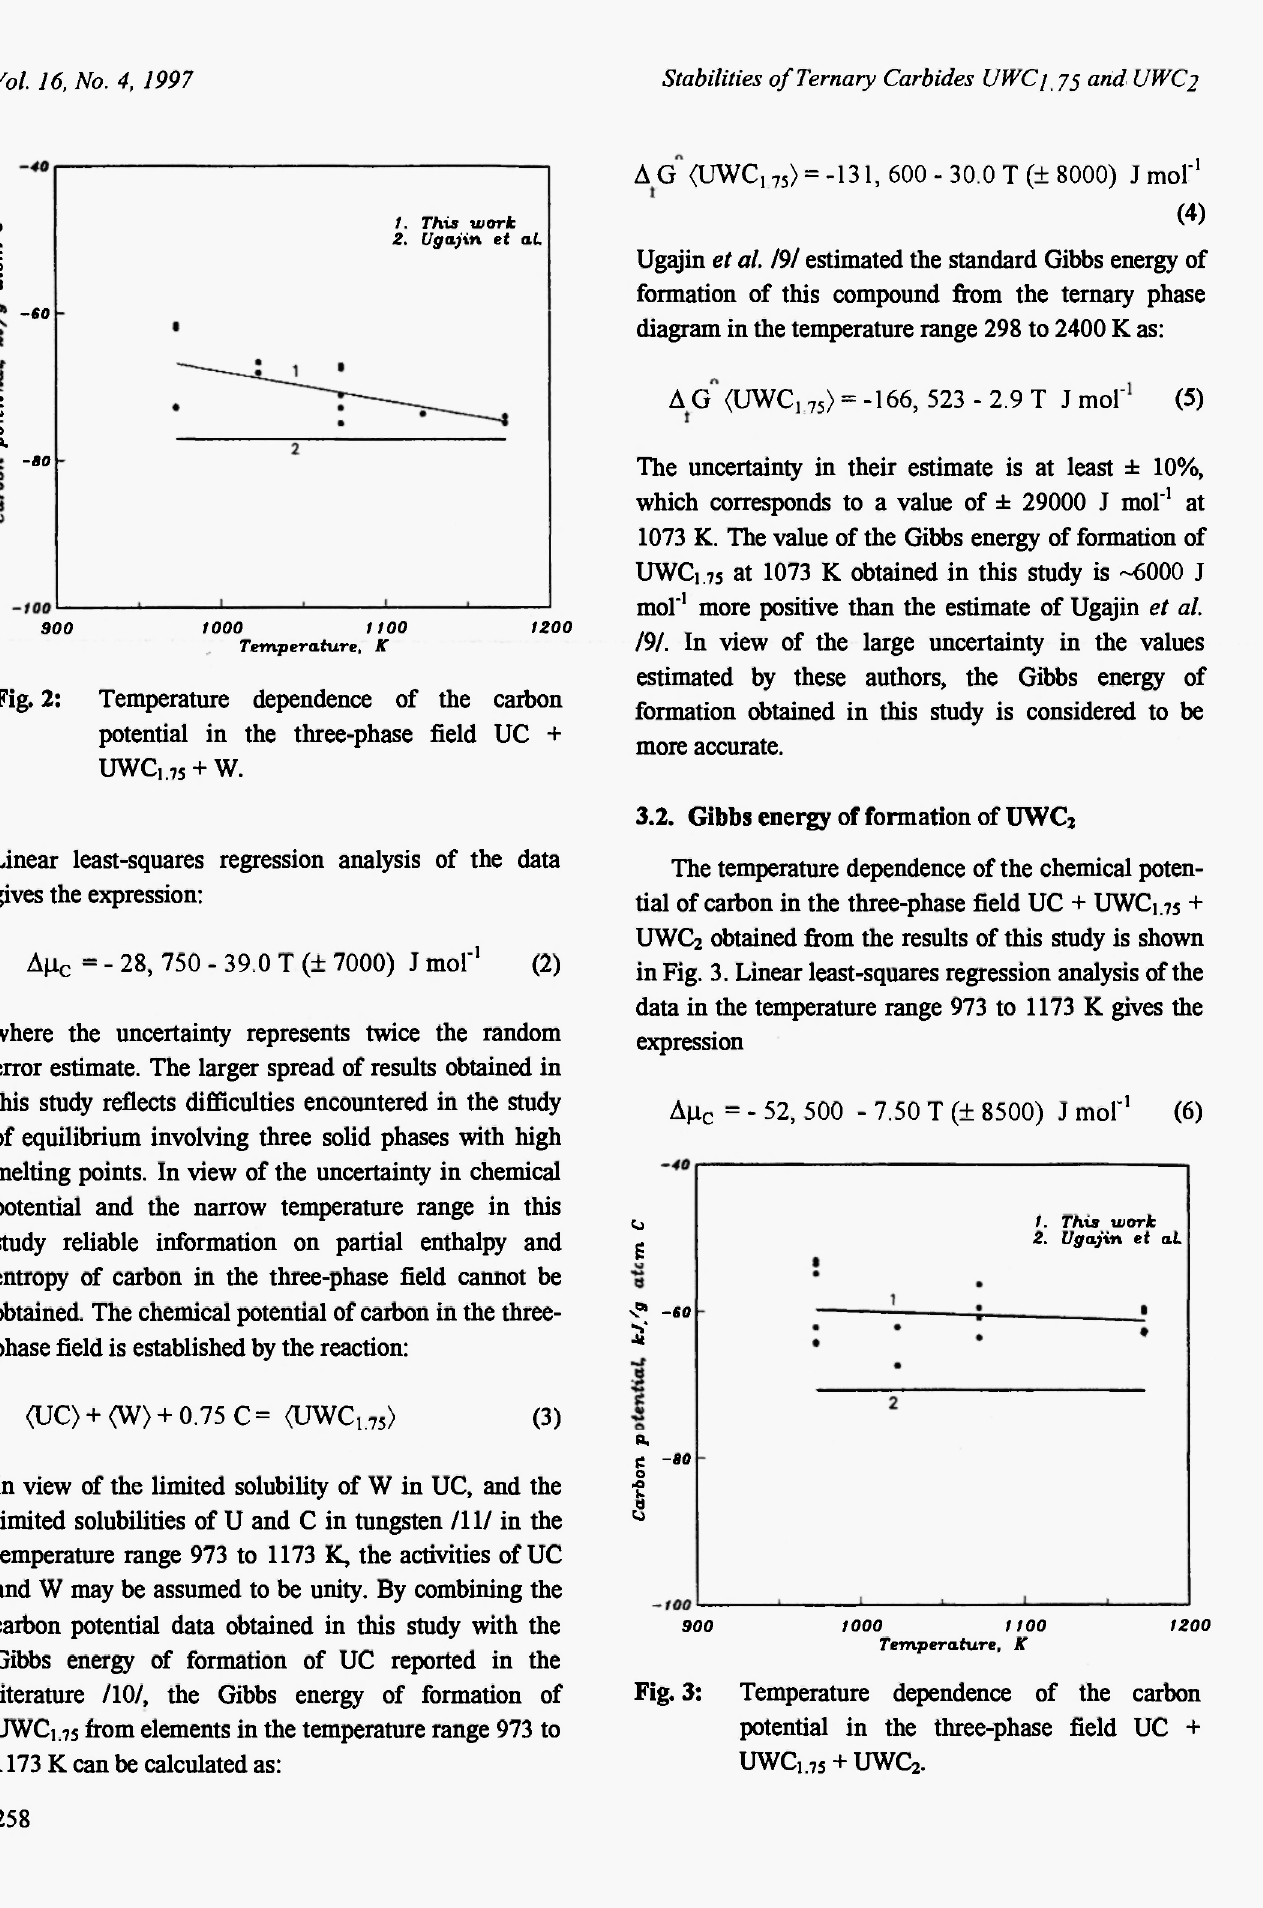
Fig. 3: Temperature dependence of the carbon potential in the three-phase field UC + UWC1.75 + UWC 2